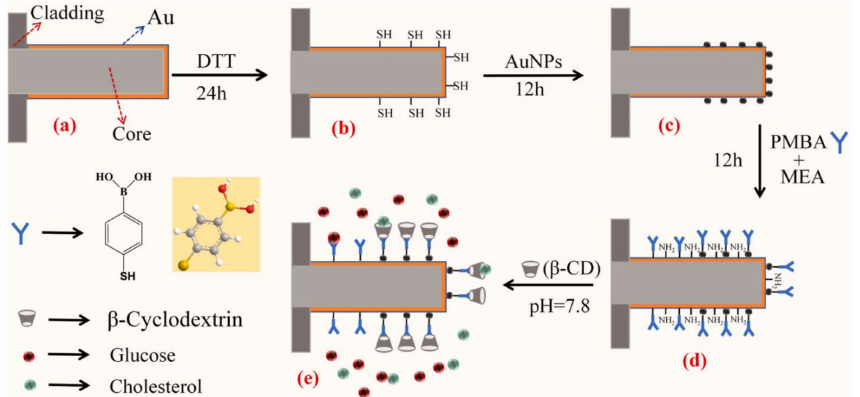
Figure 5. Process of sensor probe preparation for dual parameters measurements of glucose and cholesterol concentrations. ( a ) The Au coated fiber tube is immersed in dithiothreitol (DTT) for 24 h to form the free mercapto groups in ( b ). ( c ) The Au nanoparticles (AuNPs) are connected to the Au film by the mercapto groups. ( d ) After which the sensor probe is immersed in PMBA and mercaptoacetamide (MEA) mixture for 12 h and ( e ) immersed in 0.01 M β -CD solution that was prepared using PB buffer solution of pH = 7.8. Reprinted with permission from Ref. [4]. Copyright 2022, Elsevier.